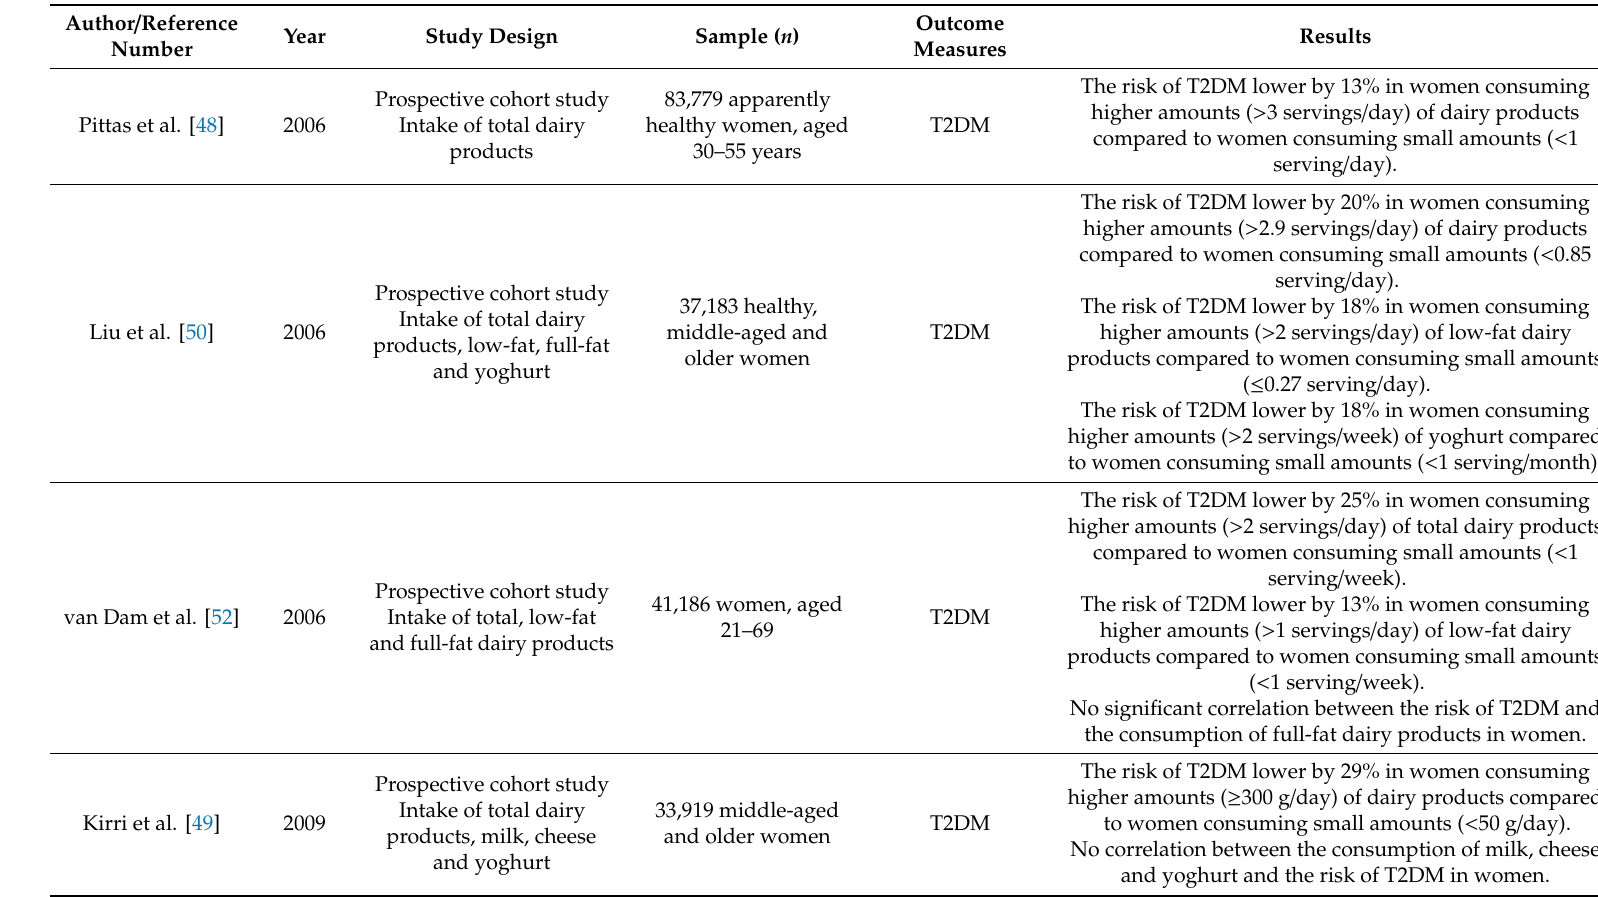
Table 2. The influence of dairy product intake on the risk of type 2 diabetes mellitus (T2DM) in